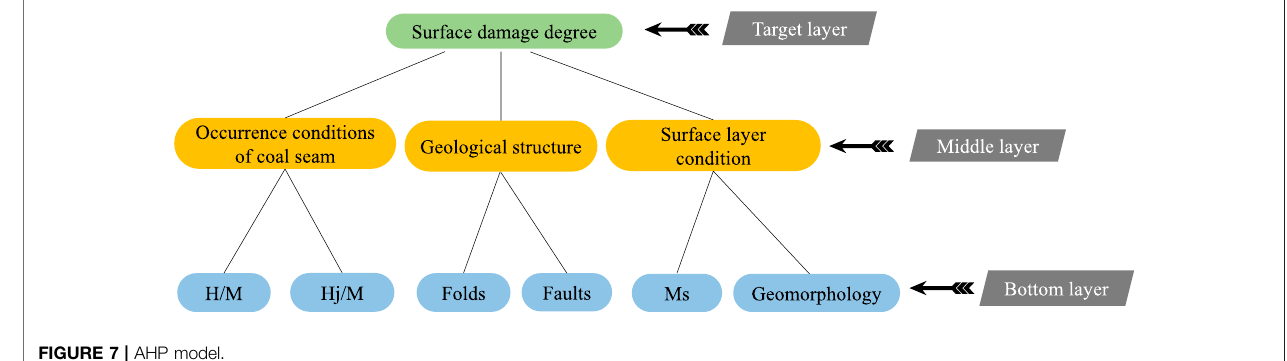
FIGURE 7 | AHP model.